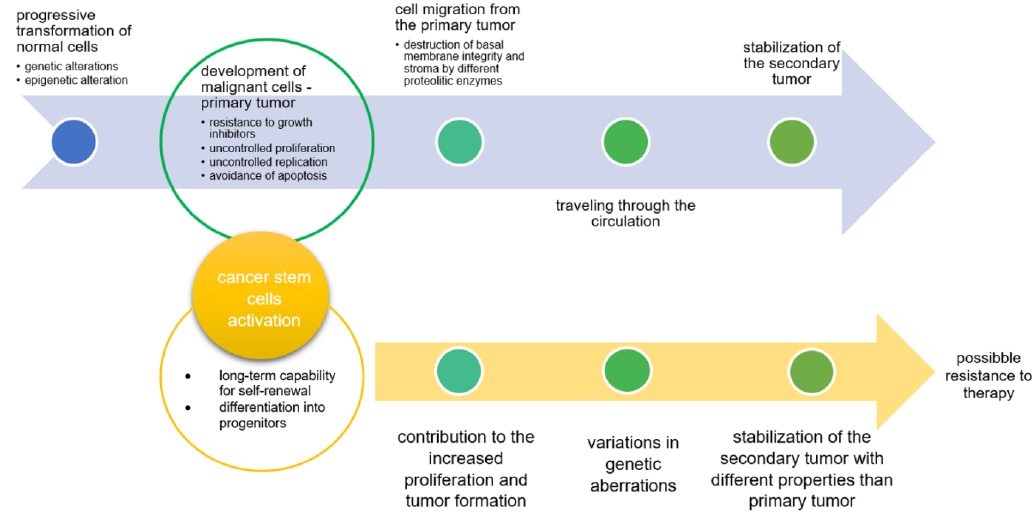
Figure 1. Steps in tumor progression [2].